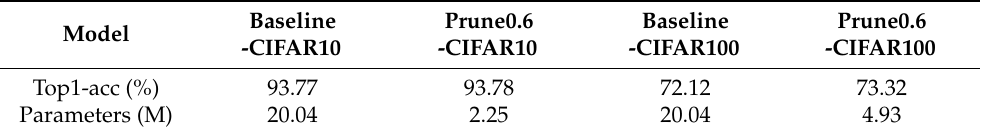
Table 2. Pruning performance verification of VGG16 on the CIFAR